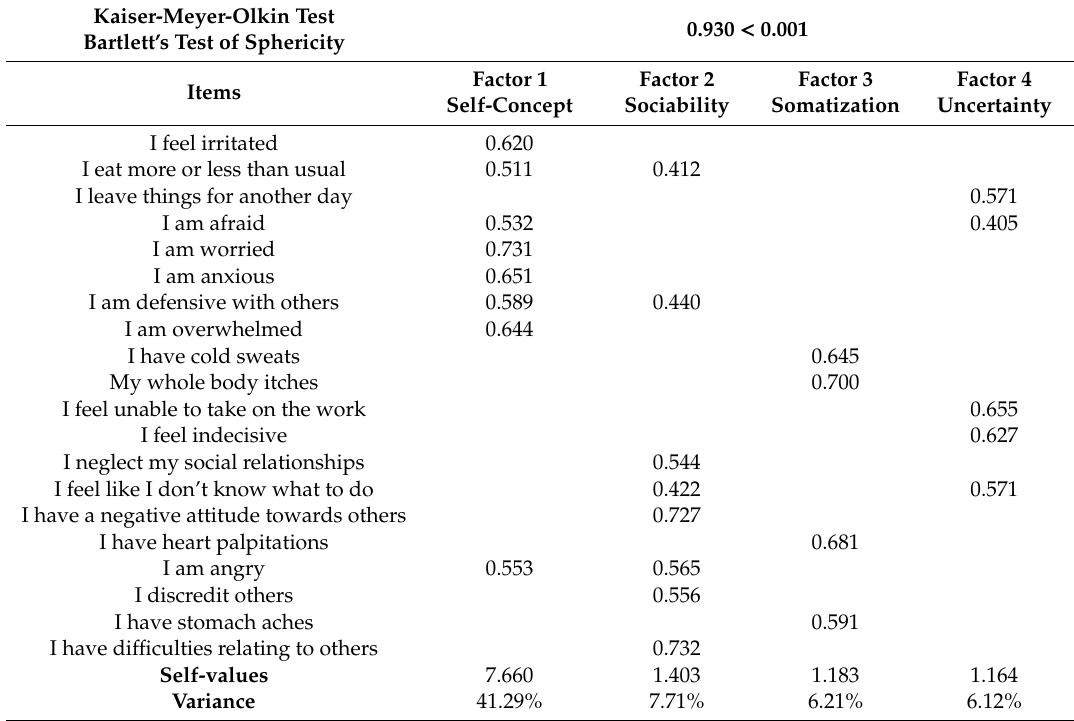
Table 1. Factorial analysis of the questionnaire: rotated component matrix.